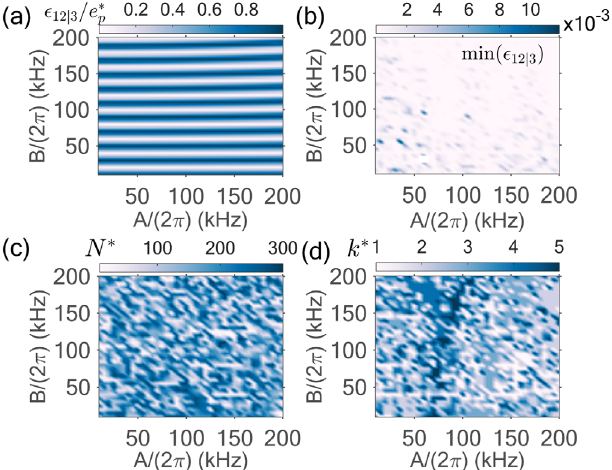
FIG. 5. Controlling a target nuclear spin with parameters ð A; B; ω L Þ ¼ 2 π · ð 60 ; 30 ; 314 Þ kHz, in the presence of an un- wanted spin with HF parameters ∈ 2 π · ½ 10 ; 200 (cid:2) kHz. (a) One- tangle of the unwanted spin scaled by the maximum bound of ϵ (cid:3) 2 = 9 . The time of one sequence unit is the first resonance of p ¼ the target spin, and the number of iterations is N ¼ 25 , which maximize its one-tangle. (b) Minimization of the unwanted spin ’ s one-tangle using the first five ( k ¼ 1 ; … ; 5 ) resonances of the target spin and up to 300 pulses on the electron. Optimal sequence iterations (c) and optimal resonance (d) to minimize the unwanted spin ’ s one-tangle while keeping the one-tangle for the target spin maximal. In all plots, we consider an electron spin S ¼ 1 = 2 and the CPMG